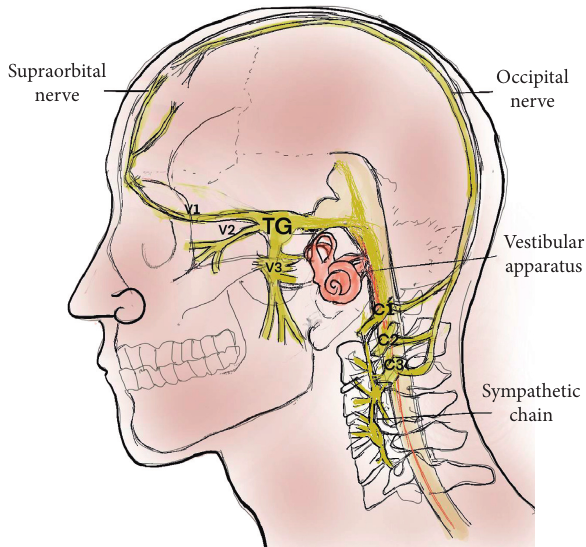
Figure 1: Cervicovestibular trigeminosympathetic system: the anatomic and functional connections between the trigeminal, vestibular, cervical, and sympathetic systems which are often involved in postconcussion syndrome. Cervical roots and the trigeminal system run proximal to each other with convergence of their afferents. The vestibulocollic and vestibulospinal tract controls the neck and truck tone. Cervical roots are in close proximity and communicate with the cervical sympathetic chains which are connections to the autonomic nervous system. TG, trigeminal ganglion; C1/2/3, cervical